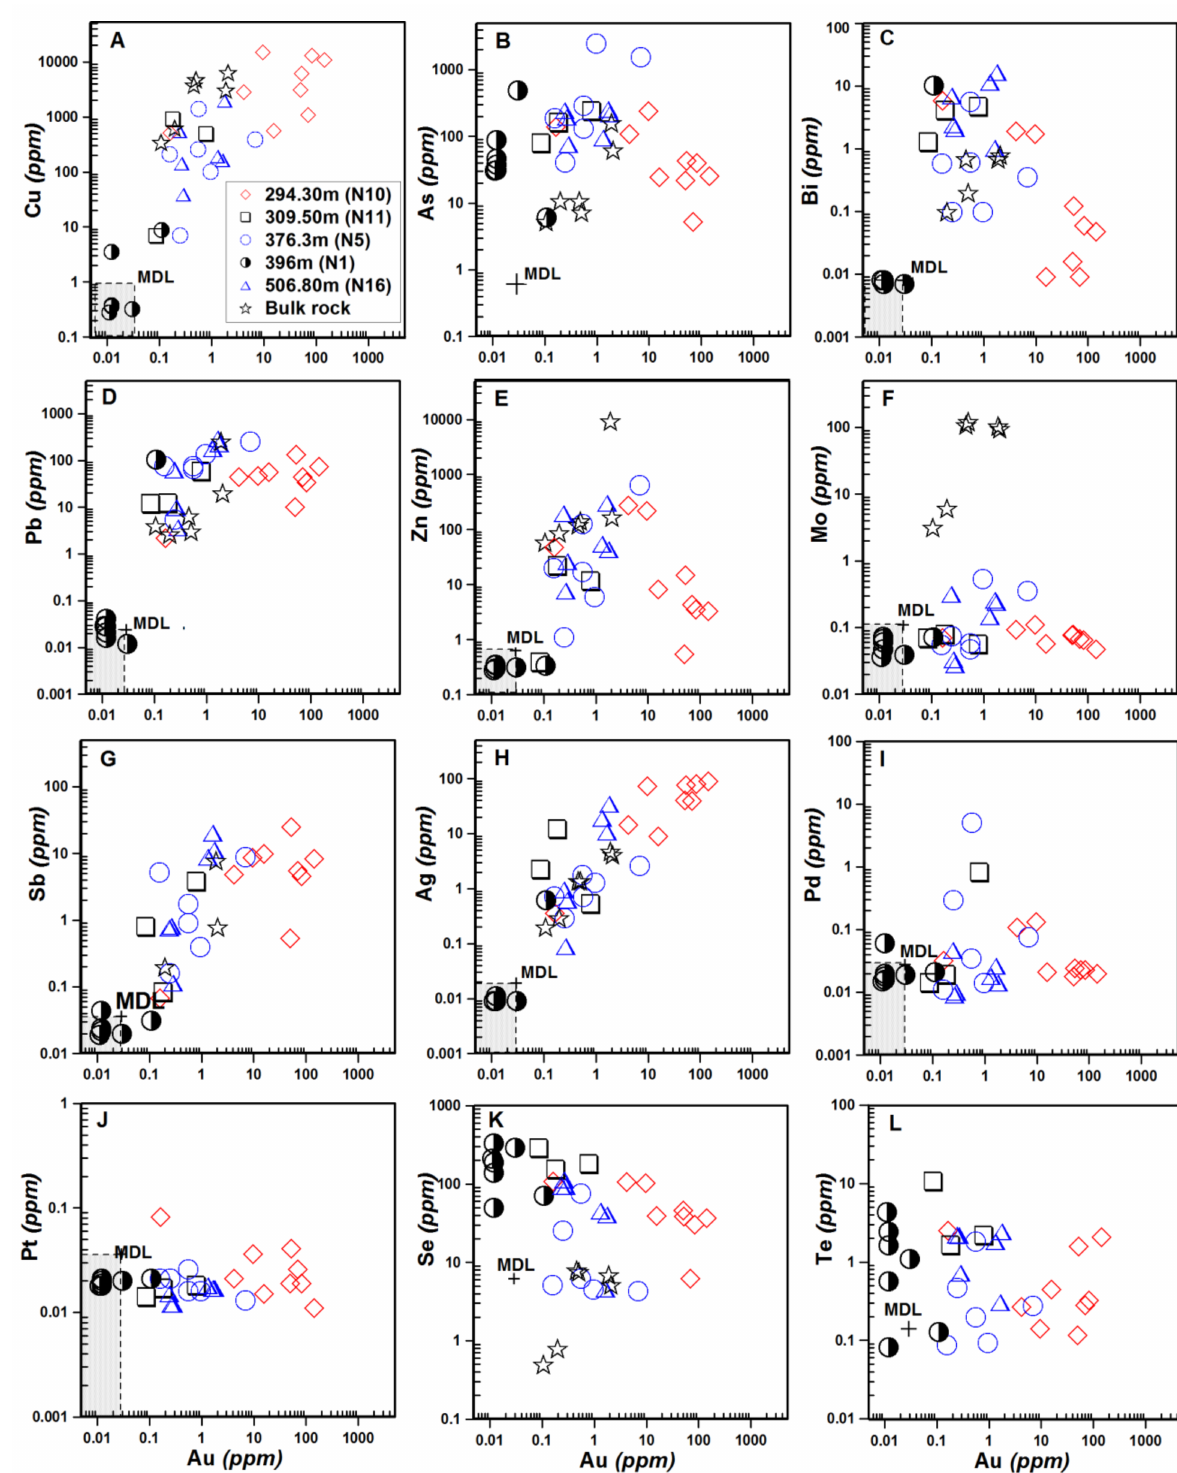
Figure 11. Log-plots of the trace element concentrations in the pyrite samples from drill hole WR272 at the Nambonga North porphyry deposit, ( A ) Au versus Cu, ( B ) Au versus As, ( C ) Au versus Bi, ( D ) Au versus Pb, ( E ) Au versus Zn, ( F ) Au versus Mo, ( G ) Au versus Sb, ( H ) Au versus Ag, ( I ) Au versus Pd, ( J ) Au versus Pt, ( K ) Au versus Se, and ( L ) Au versus Te. The bulk-rock chemical data for the Nambonga North porphyry is also